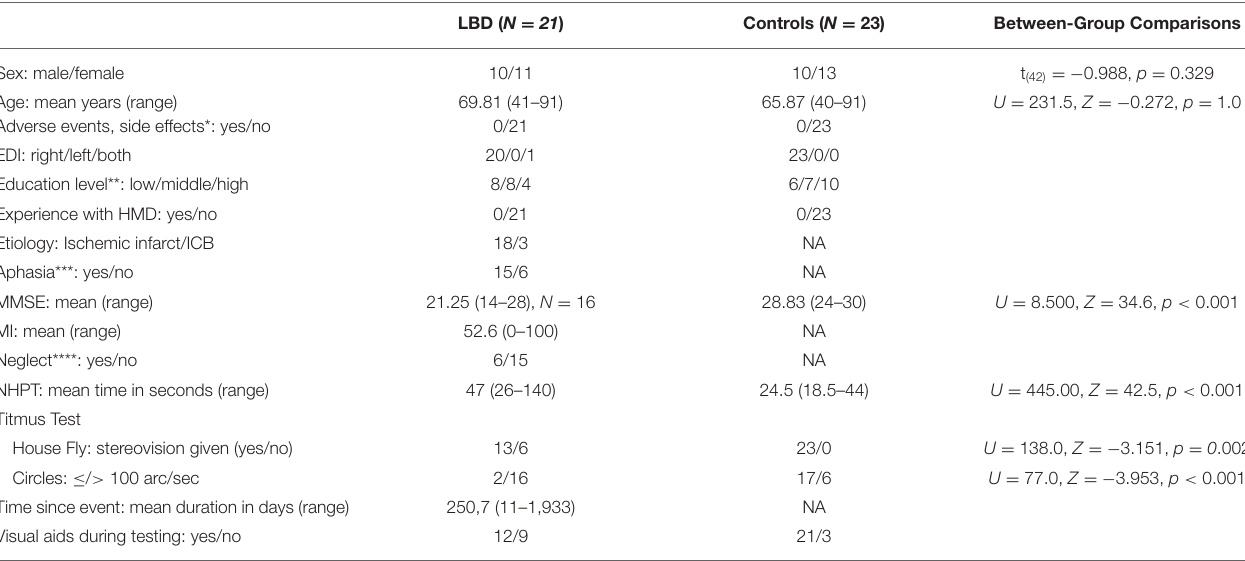
TABLE 1 | Participant’s demographics and clinical